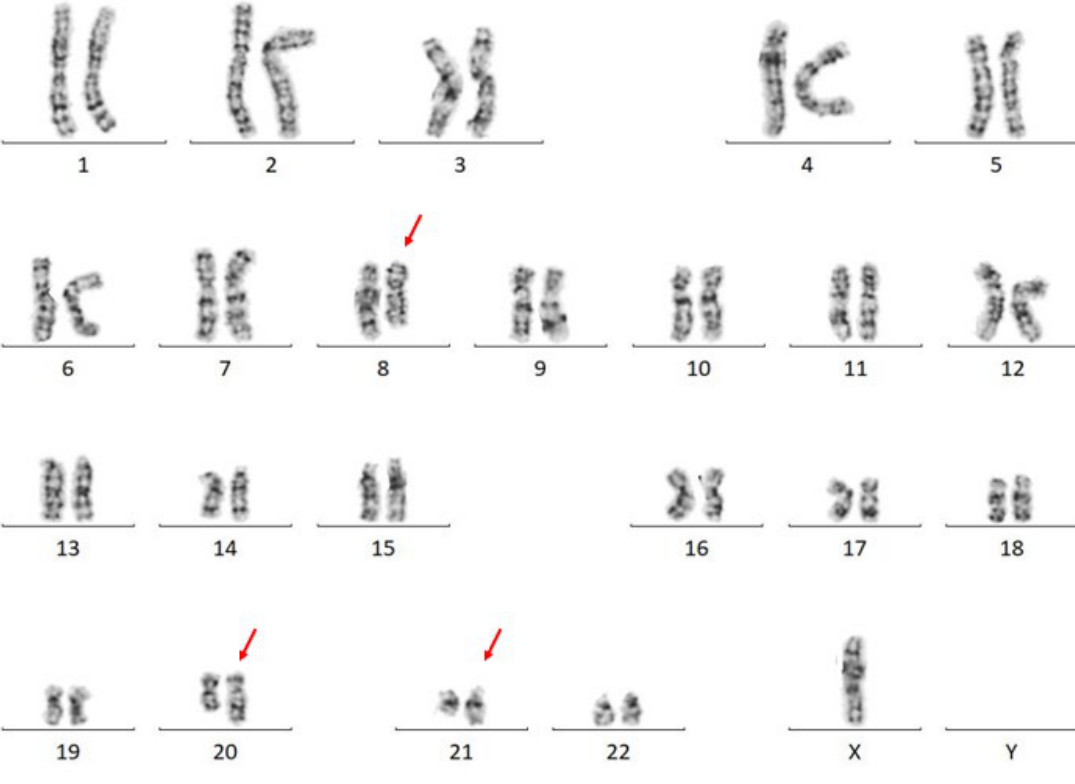
Figure 4. A representative karyogram of Patient 4: 46,X,-Y,t(8;20;21)(q22;q13.2;q22). Molecular testing confirmed the presence of gene fusion RUNX1 :: RUNX1T1 .R3R3 chr21:36231771—chr8:93029591.